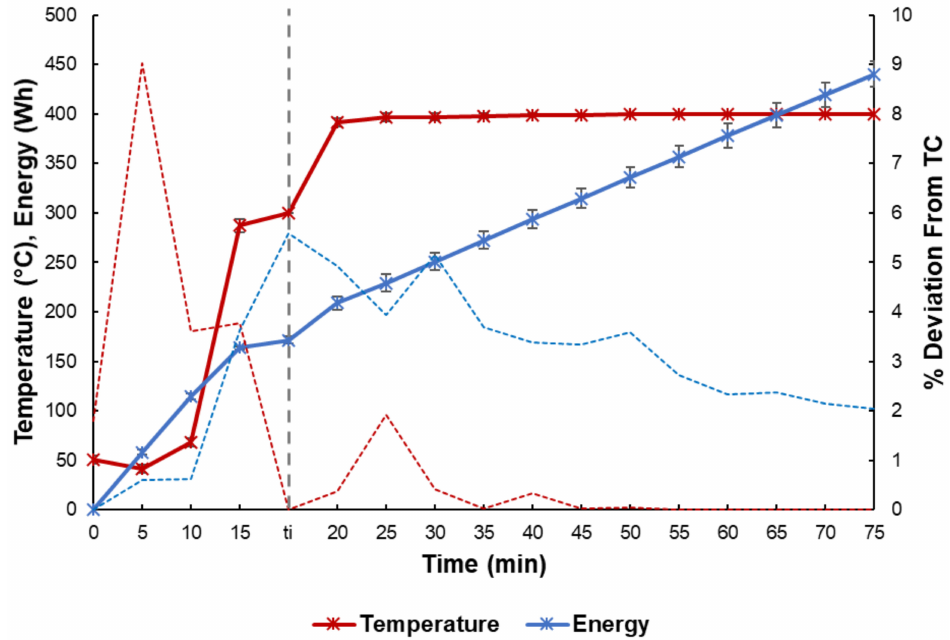
Figure 5. Temperature and energy profiles for HDC runs (solid), and their % deviation from thermal cracking (TC) runs (dashed). The time at which the temperature inside the reactor reached 300 ◦ C is denoted by t i